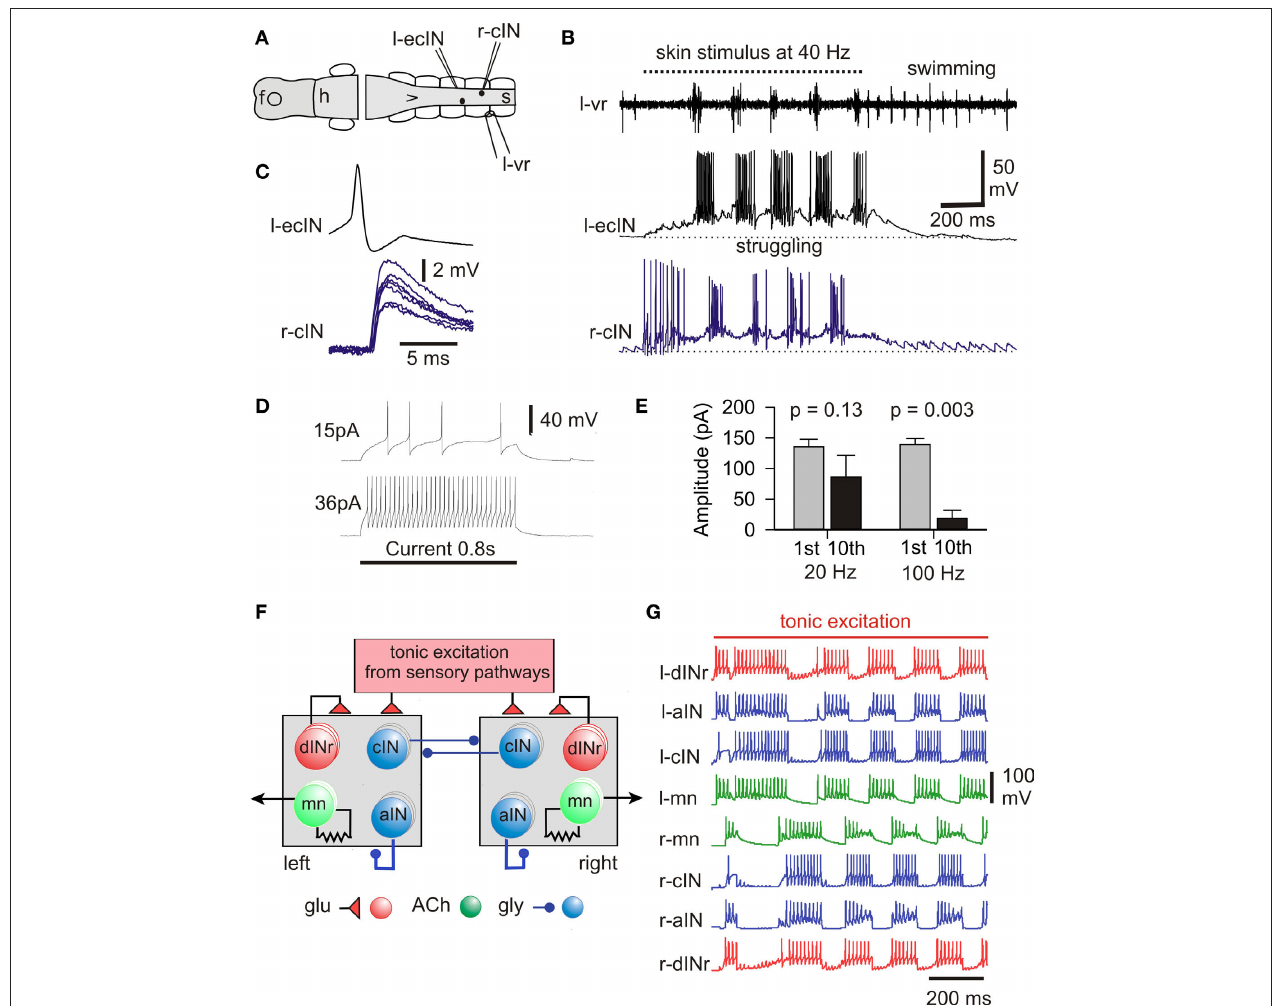
Figure  | The struggling motor pattern, the neurons responsible and its mechanism of generation. (A,B) During 40-Hz skin stimuli struggling is evoked and a cIN and ecIN recorded in whole-cell mode are recruited. When stimulation stops the motor pattern switches to swimming and recorded neurons become silent. (C) Current injection into the ecIN makes it fire an action potential which produces a short latency EPSP in the cIN. (D) Longer injected current induces